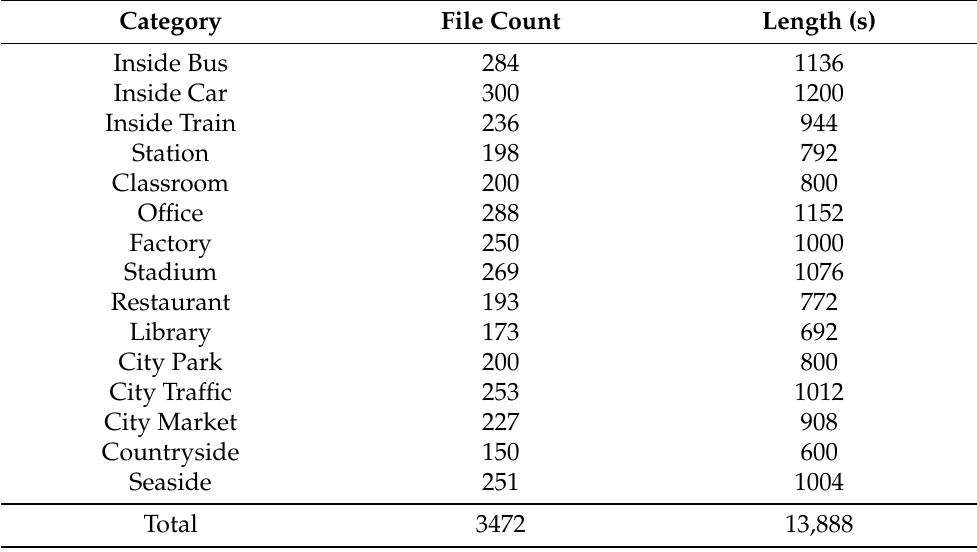
Table 3. Soundscapes corpus composition